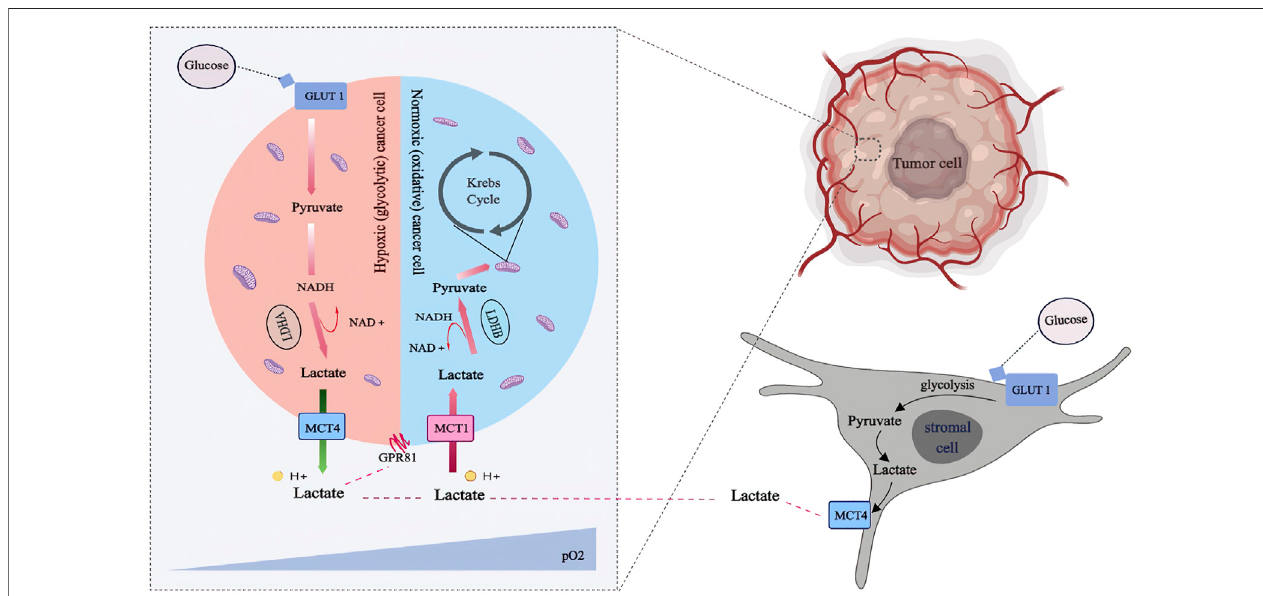
FIGURE2| Lactateshuttlinginthemetabolicsymbiosis:Lactate released through themonocarboxylatetransporter. Tumorcellswithprofuse oxygen supply(pale blue)preferentiallyutilizelactateasanoxidativefuel,whichspareglucosesuchthatmakeitavailableforbothglycolytictumorcells(paleblue)andstromalcells(palegray), via anaerobic and aerobic glycolysis, respectively. Hypoxic tumor cells and stromal cells generate lactate preferentially to fuel canonical lactate biosynthesis via Lactate Dehydrogenases (LDH) isoform A and export the lactate out of the cells via MCT4. Then the lactate can be transported into normoxic tumor cells via MCT1 and subsequently transformed into pyruvate via LDHB for ATP